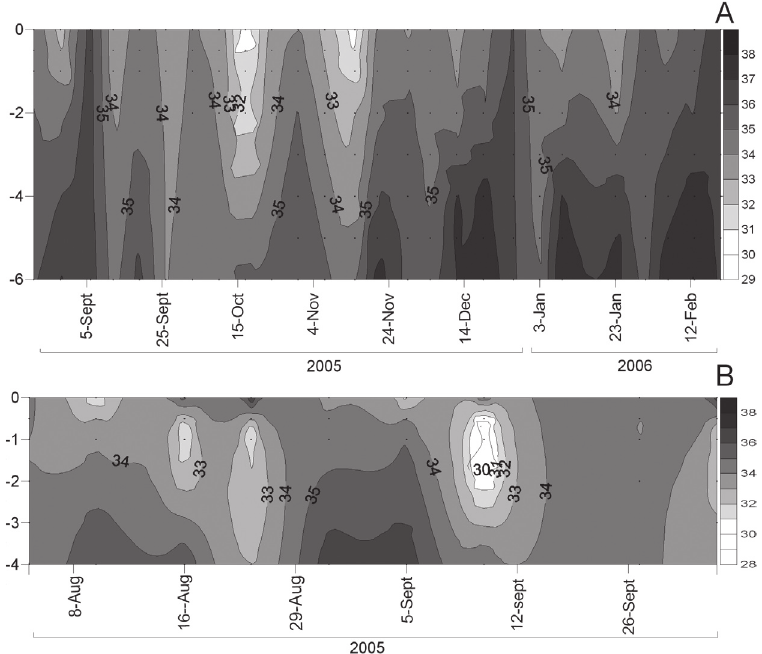
Fig . 3. – temporal-spatial distribution of salinity in alfacs (a) and Fangar (B) Bays. depth in metres.